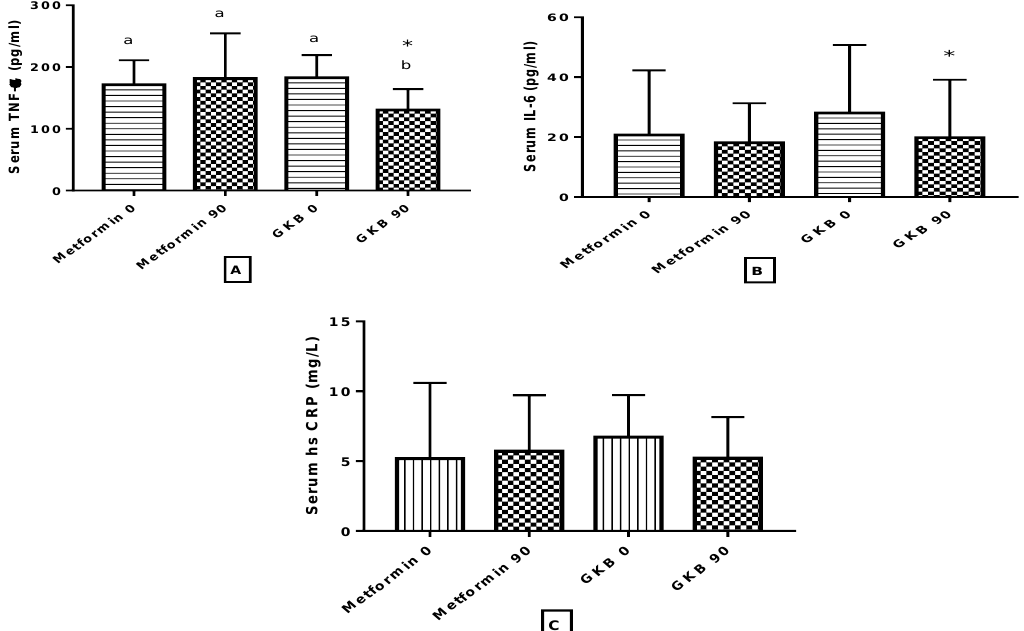
Figure 5. Effect of Gingko biloba extract (GKB) on the serum level of (A) TNF-α (B) IL6 (C) hs-CRP of patients with metabolic syndrome. Values were presented as mean ± S.D; * significantly different compared with baseline values (paired t -test, P <0.05).Values with non-identical letters (a,b) were significantly different among each other (ANOVA, P